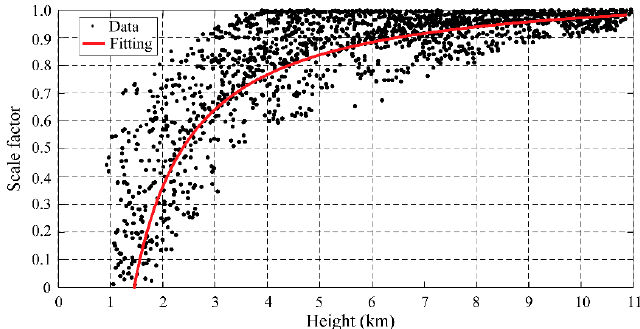
Figure 13. The scale factor changes with the height of the intersection point between the effective side signals and the side face of the tomographic area during the period of DOY 213-243, 2017. Table 5. The fitting coefficient and accuracy of the Yao model.